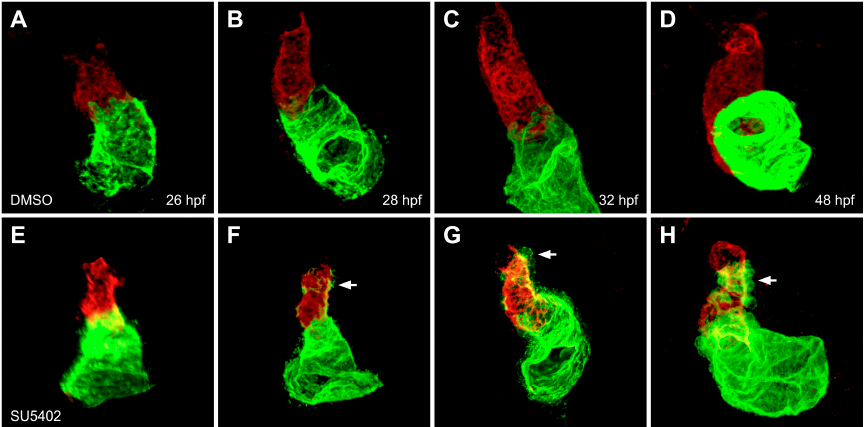
Figure 5. FGF signaling is required to maintain ventricular cardiomyocyte identity. In contrast to control embryos treated with DMSO ( A – D ), embryos treated with SU5402 beginning at 18 hpf ( E – H ) exhibit gradual accumulation of ectopic Amhc (arrows), accompanied by diminishing levels of Vmhc in the ventricle, between 28 and 48 hpf ( F – H ). Red fluorescence indicates localization of Vmhc, and green fluorescence indicates localization of Amhc. Images adapted from [27].